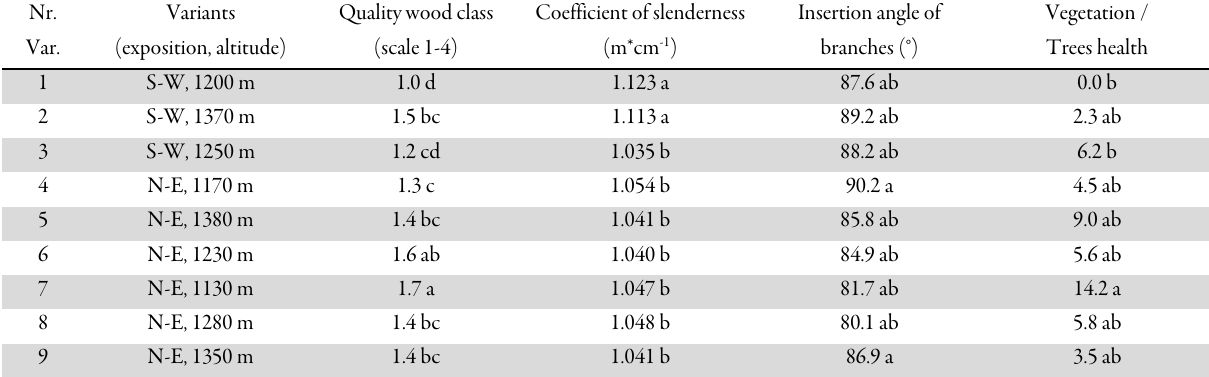
Table 2. Elements of the wood quality and vegetation of the spruce ( Picea abies ) in nine plots, depending on the exposition and altitude